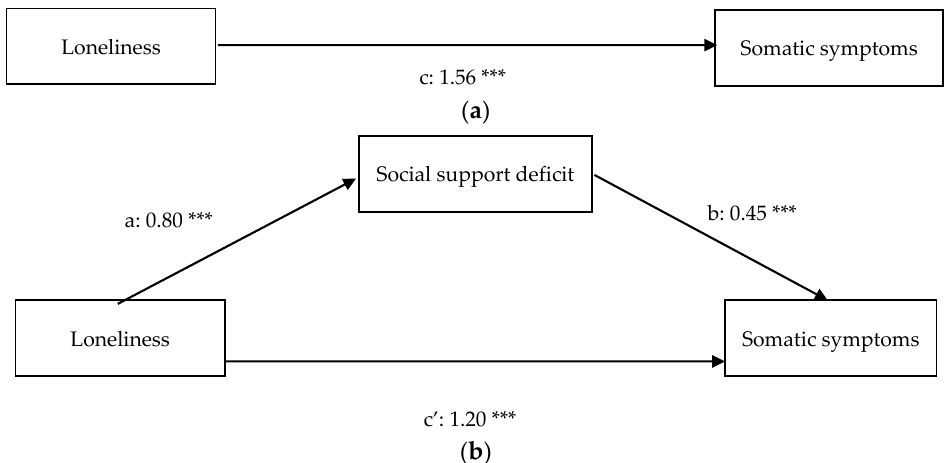
Figure 2. ( a ) Total relationship between loneliness and depression. ( b ) Mediation of the relationship between loneliness and depression. *** p < 0.01.